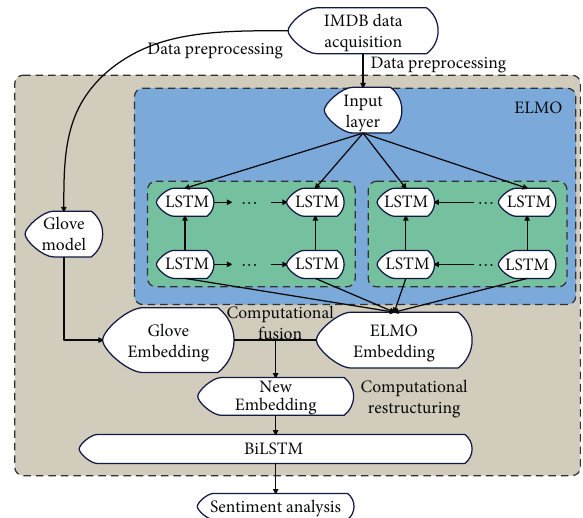
Figure 6: Flowchart of the emotion analysis model. The proposed SABG model directly trains key sentiment words by combining the Self-Attention mechanism. The structure of the SABG model is shown